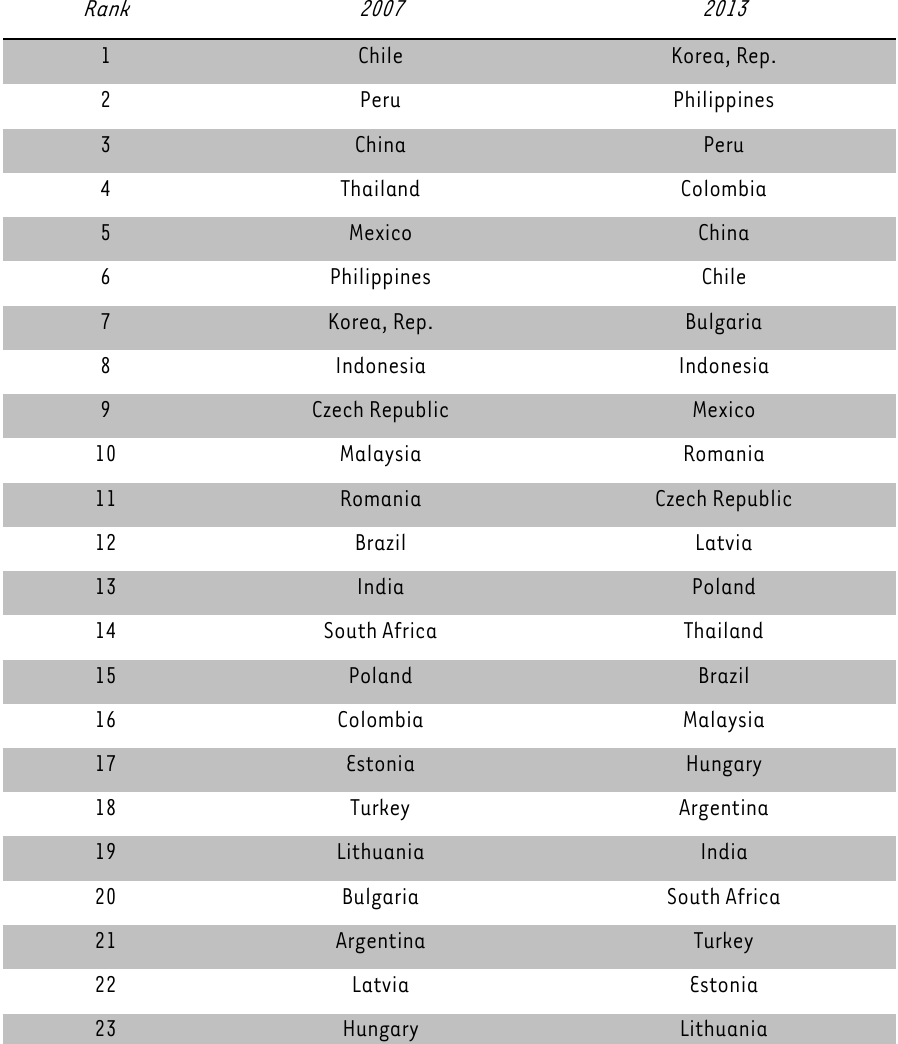
TABLE 1: National ranking in terms of resilience indicator